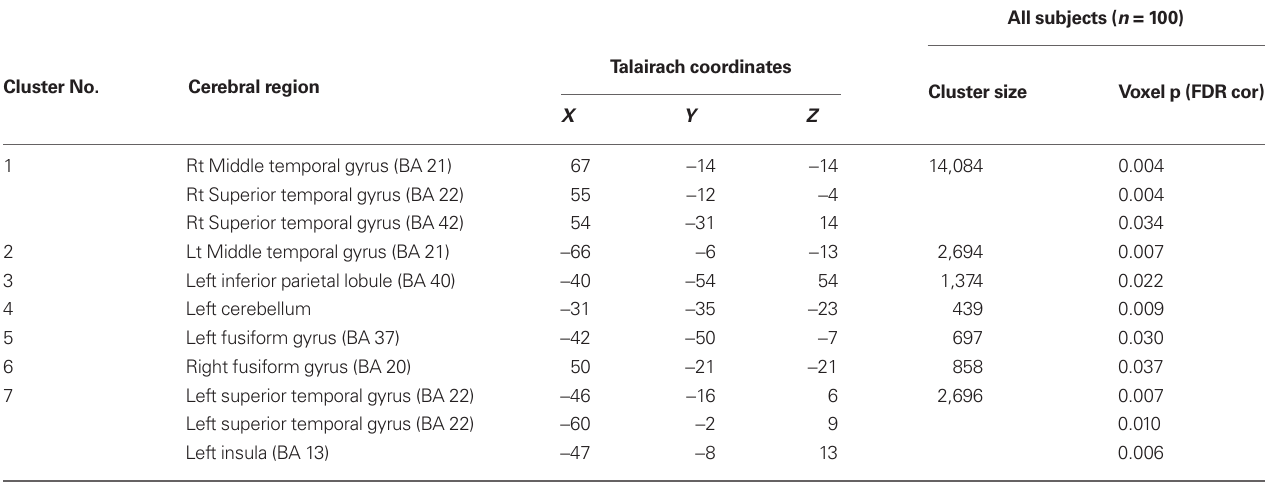
Table 2 | gestational age at birth and associations with gray matter density among right-handed 6- to 10-year-old children born between 28 and 41 gestational weeks.